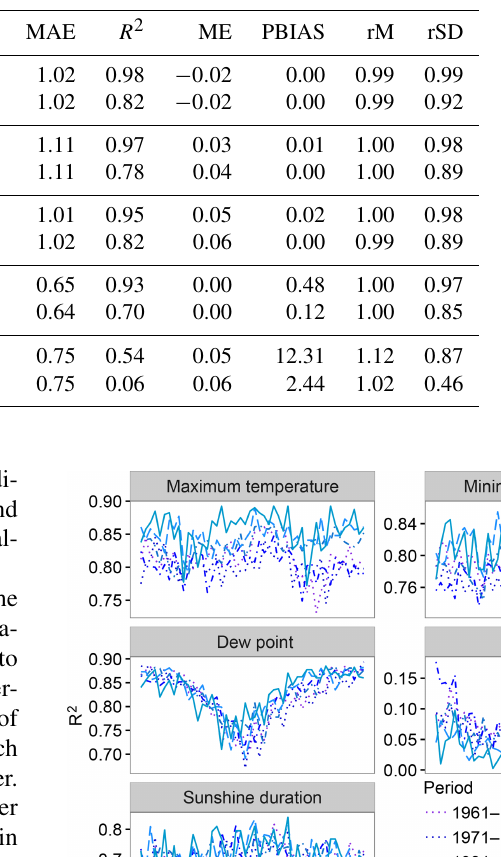
Table 4. Spatial and temporal validation of the interpolation process. Values for the following validation statistics are provided: (i) mean absolute error (MAE), (ii) coefficient of determination R 2 , (iii) mean error (ME), (iv) percent bias (PBIAS), (v) ratio of mean values (rM) and (vi) ratio of standard deviation (rSD).